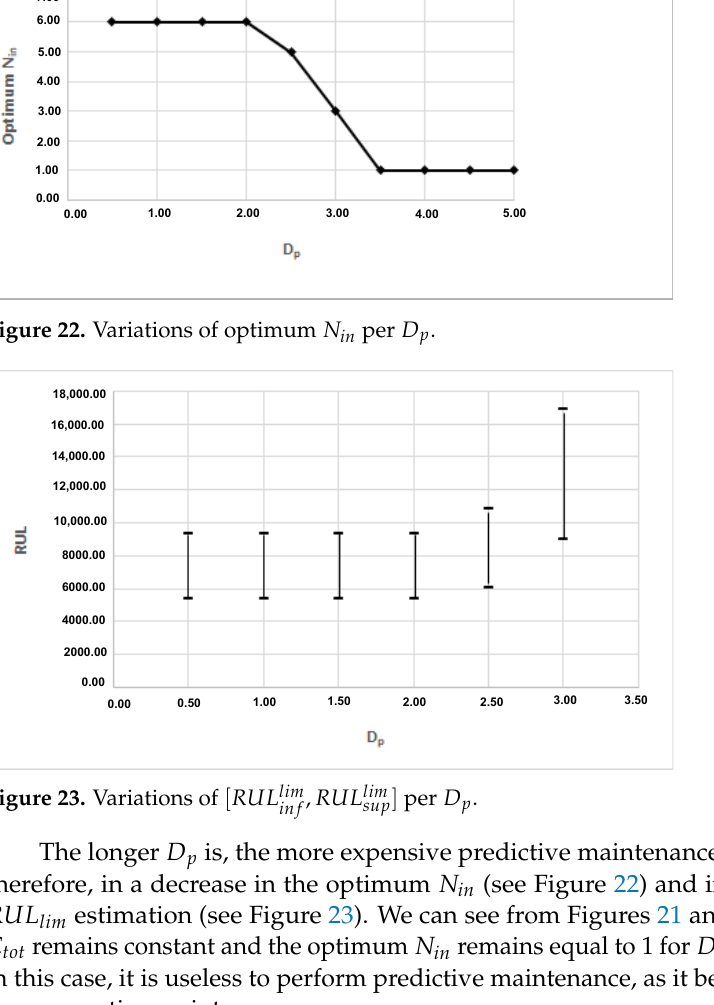
, RUL lim sup ] per D p . inf